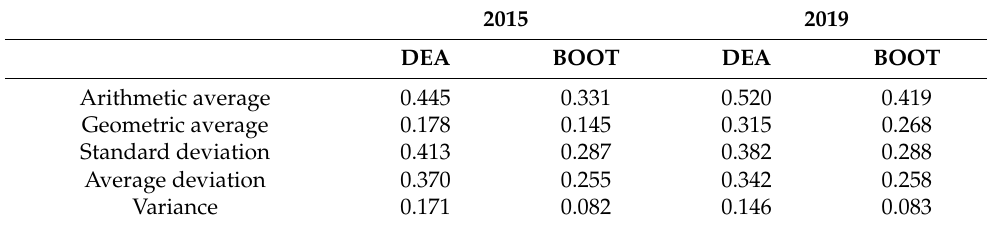
Table 4. Statistical results of DEA and DEA-BOOT